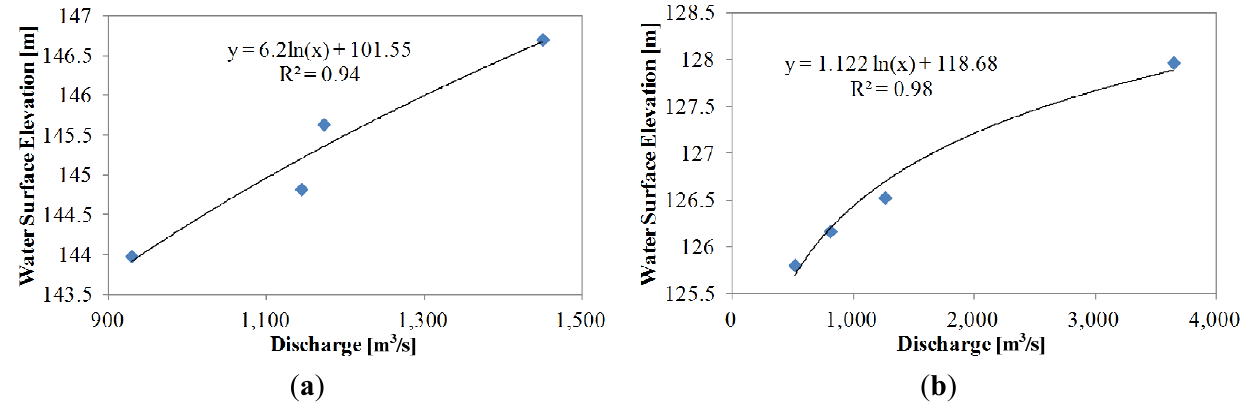
Figure 6. Examples of rating equations between discharges and water surface elevations. ( a ) Rating equation at XS9 in the Montezuma reach; ( b ) Rating equation at XSI in the Petersburg reach.